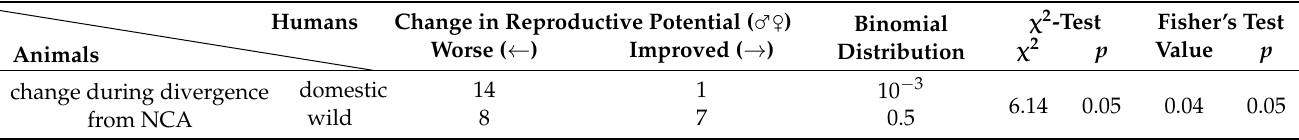
Table 5. Correlations between the effects of the co-directed changes in the expression of orthologous genes on human reproductive potential and on the divergence of domestic and wild animals from their NCA (without guinea pig and cavy, the correlations for which are outlined in Tables 2 and 3).